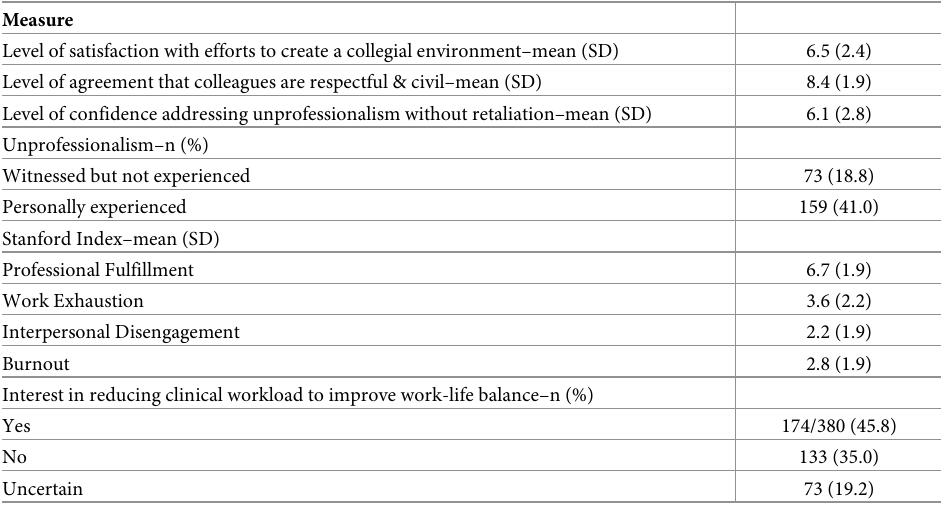
Table 2. Physicians’ perceptions of the organizational